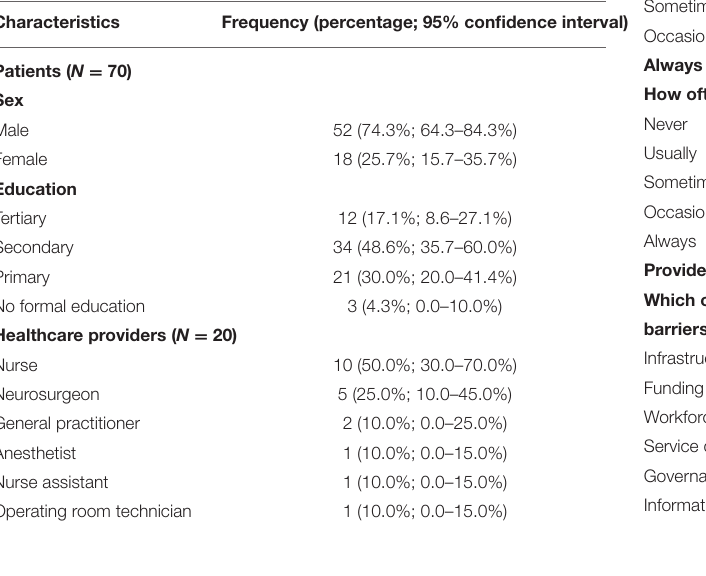
TABLE 1 | Sociodemographic characteristics of patients and healthcare providers that responded to the survey. Characteristics